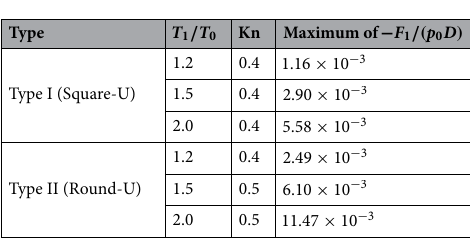
T T 1 / 0 in the case of